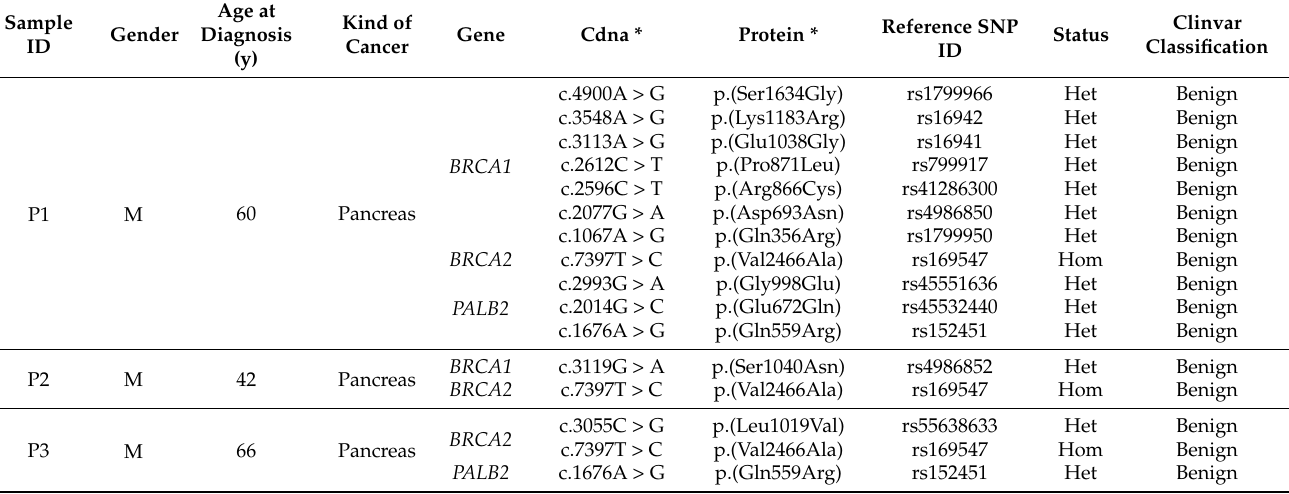
Table 2. Full list of single-nucleotide variants and small ins/del identified in each analyzed patient. Pathogenic variants are reported in